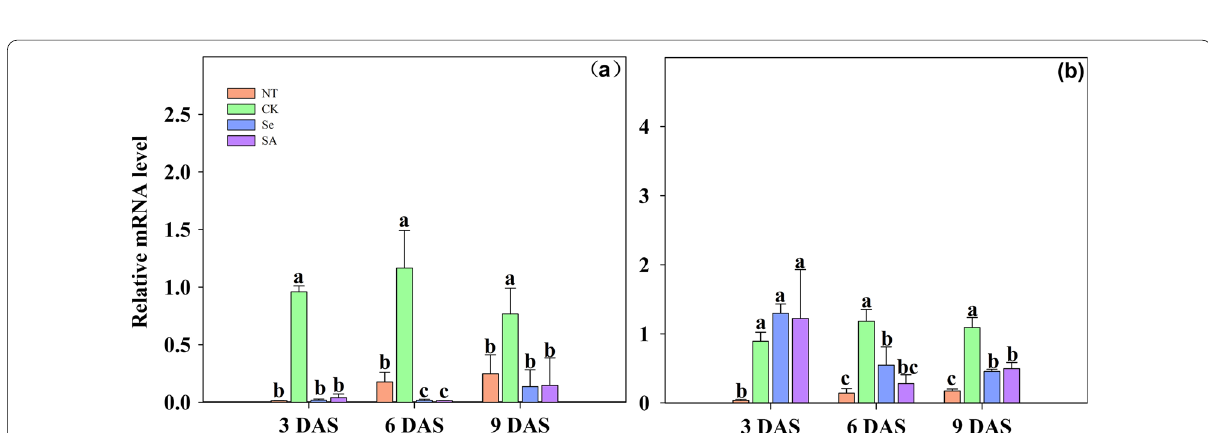
Fig. 7 Relative expression levels of OsNCED1 of primed and non-primed rice seeds under control temperature and chilling stress. a EZ18; b LY287. DAS, days after sowing; EZ18, ezao18; LY287, liangyou287; NT, no priming-normal temperature control; CK, no priming-chilling stress; Se, Selenium priming-chilling stress; SA, Salicylic priming-chilling stress. Error bars indicate standard error (n differences at the 5% level according to LSD test among four treatments within the same DAS of the same